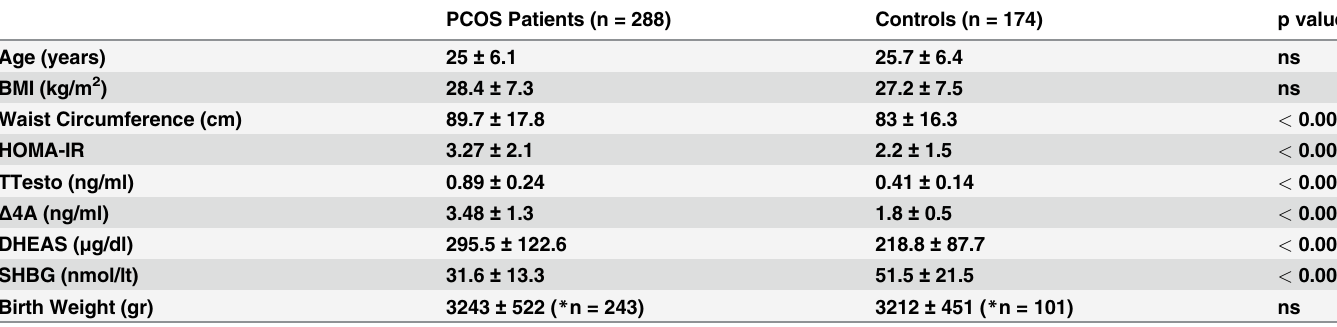
Table 1. Comparison of important characteristics between patients with PCOS and controls.